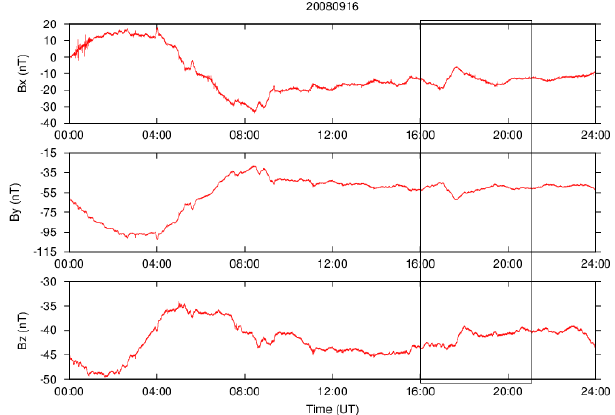
Fig. 5. An example of the daily geomagnetic variations. The first, second, and third panels indicate X,Y, and Z components on 16 September 2008,